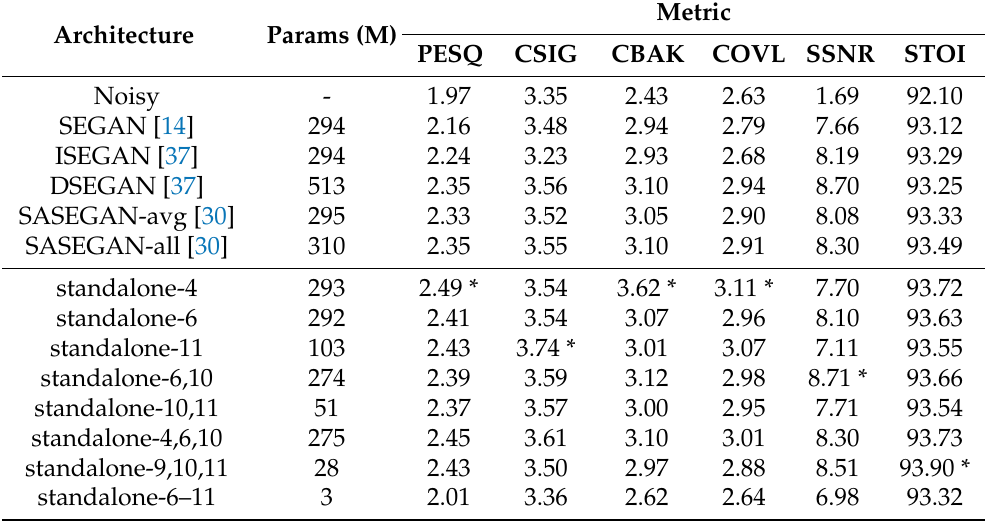
Table 1. Effects of the stand-alone self-attention layer(s) on speech enhancement GANs (SEGANs). We denote the proposed architecture with the stand-alone self-attention layer(s) at the l th (de)convolutional layer(s) as standalone-l . Values that overtake all baseline systems are in bold. Values with an asterisk are the best ones achieved for each